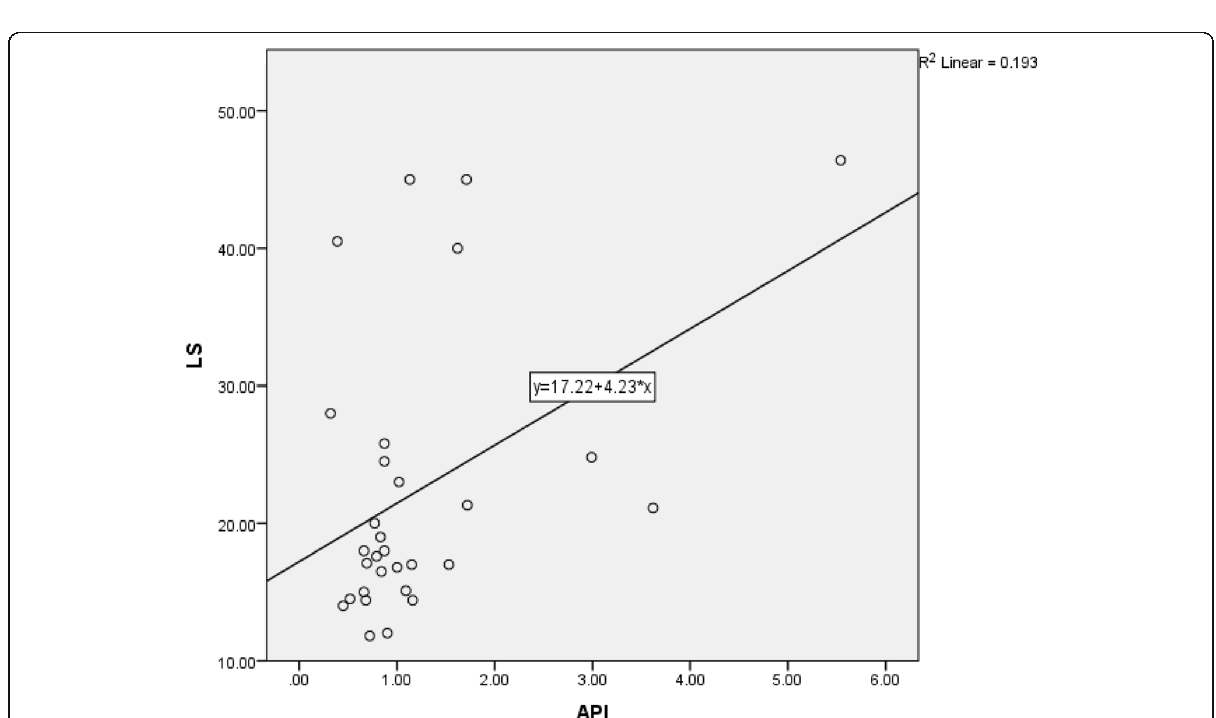
Fig. 5 Scatter plot for the correlation between LS and